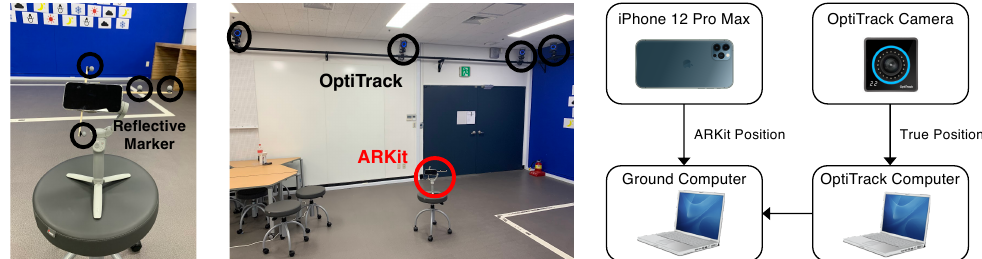
Figure 10. Experimental setup for the quantitative evaluation of ARKit. Four reflective markers were attached to the iPhone device (ARKit) to obtain the ground-truth moving trajectories from the OptiTrack motion capture systems. We acquired the true position of the VIO sensor platform in the 3D space and quantitatively evaluated the positioning accuracy of Apple